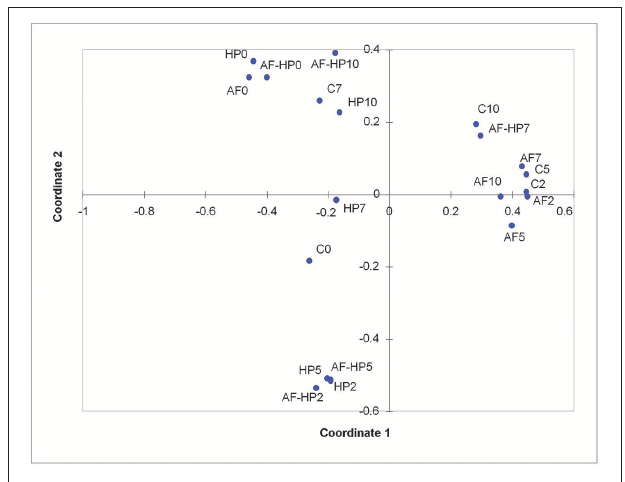
FIGURE 3 | Principal Coordinates analysis (PCoA) of the dissimilarities between controls and treated sea bream samples during refrigerated storage. Controls packed in films without activation with antimicrobials (C); samples packed in films activated with thymol plus enterocin AS-48 (AF); samples packed in films without activation and treated by high-hydrostatic pressure (HP); samples packed in activated films and treated by high-hydrostatic pressure (AF-HP). Sampling was performed at days 0, 2, 5, 7, and